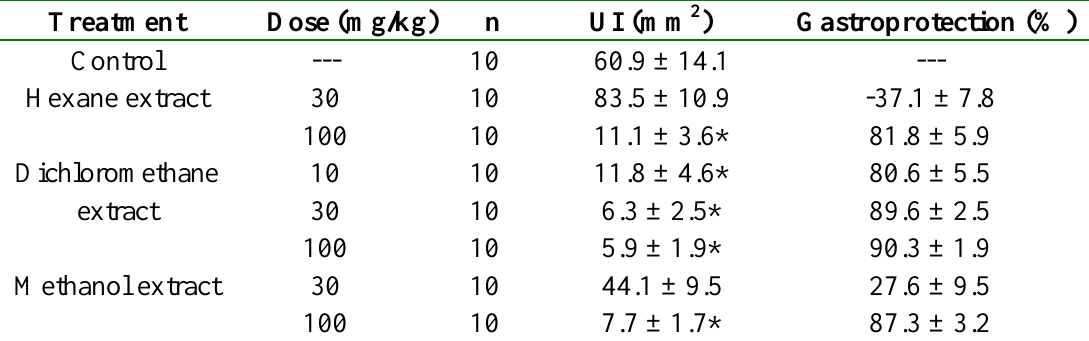
Table 1. Gastroprotective effect of Tithonia diversifolia extracts on ethanol-induced ulceration in rats.